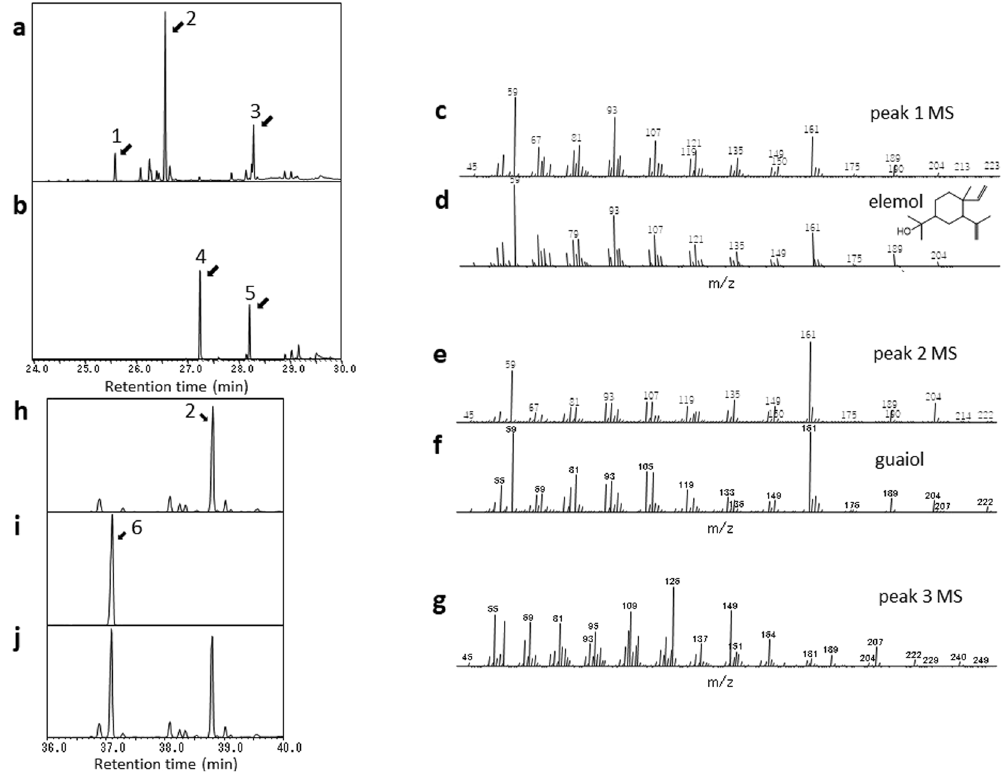
Figure 2. Gas chromatography-mass spectrometry (GC-MS) analysis of the ChTPS1 product. The ChTPS1 product extracted from E . coli (pRSF-ChTps1a and pAC-Mev/Scidi/Aacl) was subjected to GC-MS. Total ion chromatograms (TIC) of the ChTPS1 product ( a ) and of the empty vector product (control) ( b ) MS of Peak 1 ( c ) MS of elemol in the database ( d ) MS of Peak 2 ( e ) MS of guaiol in the database ( f ) MS of Peak 3 ( g ) TIC around the ChTPS1 Peak 2 area ( h ) TIC of the authentic guaiol standard ( i ) and TIC of the ChTPS1 product and guaiol mixture ( j ). As for the GC-MS analysis conditions, such as the heating-up program, for ( h , i and j ) see ref. 36